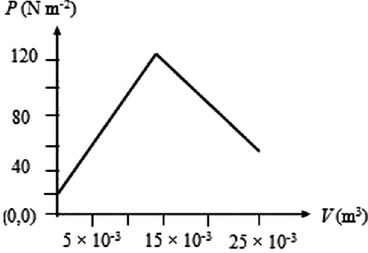
FIG. 28. Pressure-volume graph requesting quantitative